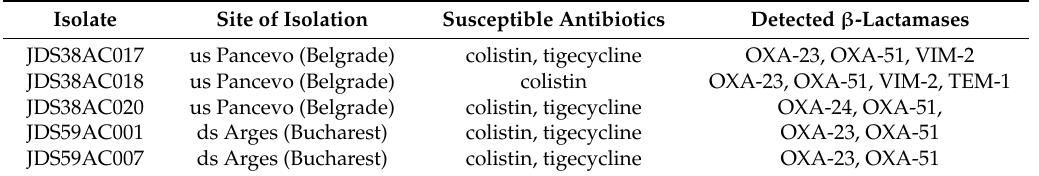
Table 3. Detected resistance genes in carbapenem resistant Acinetobacter baumannii ; us = upstream; ds =